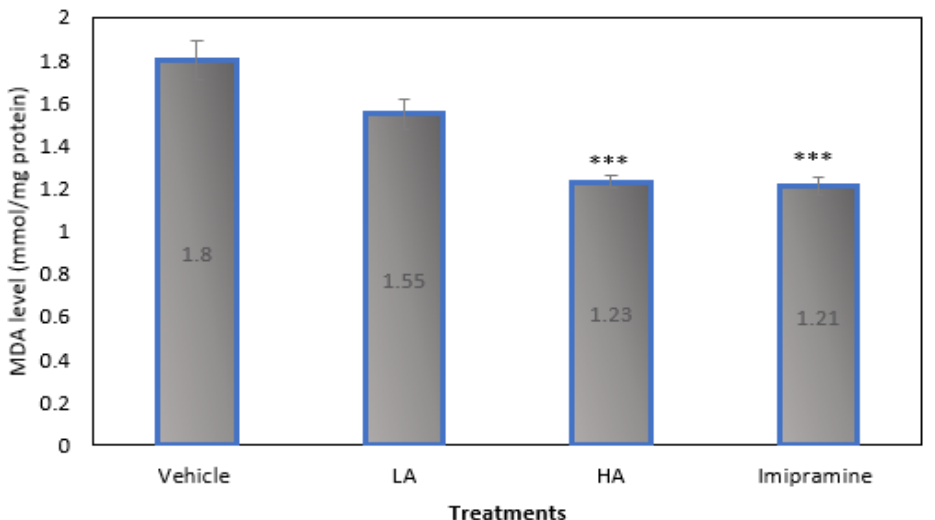
Figure 5. The effect of apigenin and imipramine on brain malondialdehyde (MDA) levels. Data are expressed in mean ± SEM (n = 8). Data were evaluated using a one-way analysis of variance (ANOVA) and Tukey ’ s test. *** p < 0.001 when compared to the vehicle control group. LA: low dose of Apigenin (25 mg/kg); HA: high dose of Apigenin (50 mg/kg); Imipramine: standard antidepres- sant (15 mg/kg); Vehicle; 0.2% carboxy methyl cellulose (CMC).